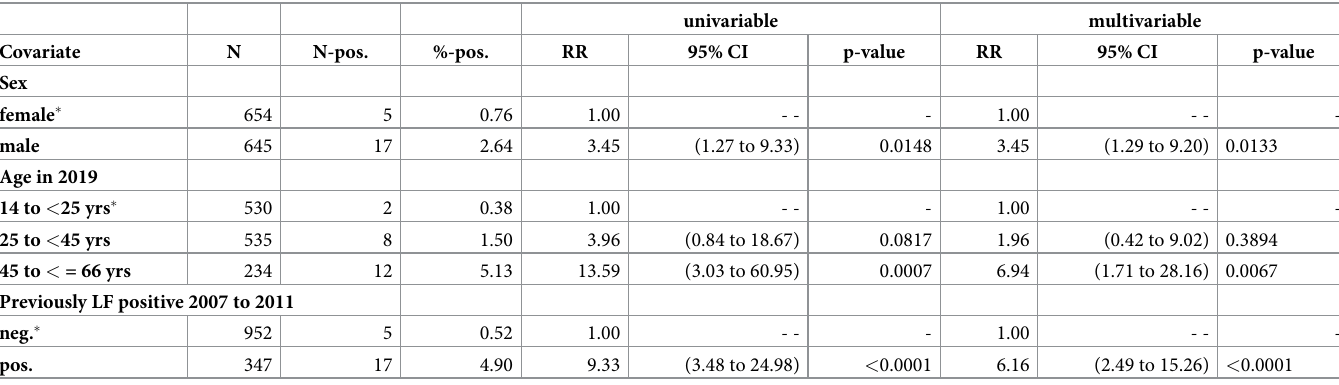
Table 3. Association of various factors with LF result in 2019 Uni- and multi-variable log-link regression results adjusted for within-household clustering. univariable